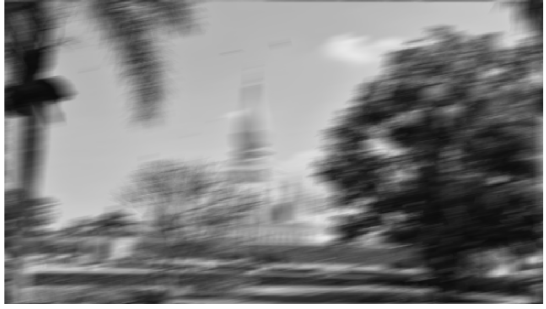
Motion Blurred Image with len = 21 and =11